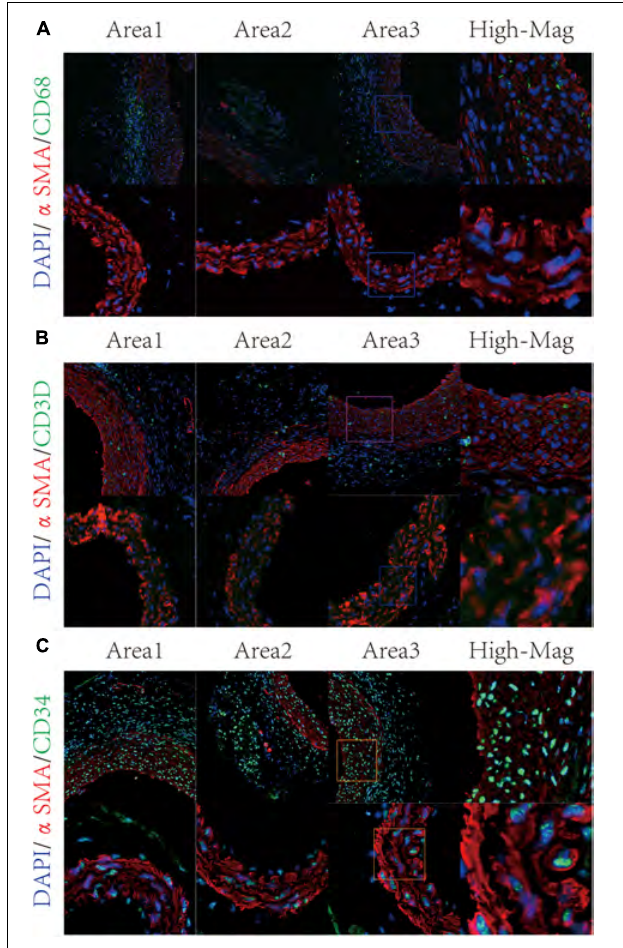
FIGURE 3 | Validation of VSMC subtypes through immunofluorescence staining. Macrophage-like VSMC was labeled by α SMA and CD68 (A) . T-cell-like VSMC was labeled by α SMA and CD3D (B) ; mesenchymal-like VSMC was labeled by α SMA and CD34 (C) .